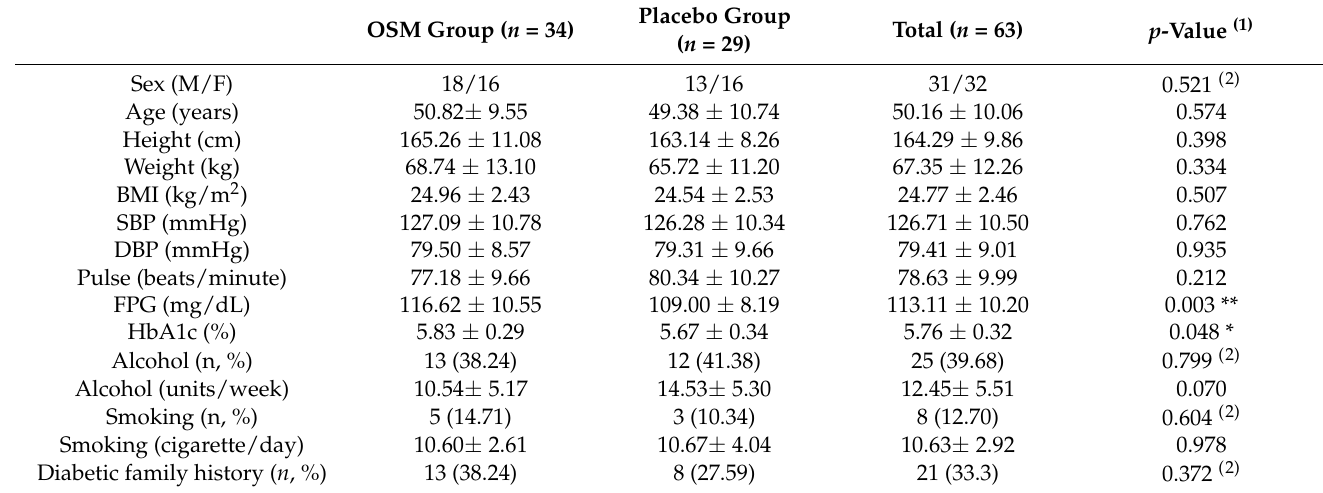
Table 2. Demographic characteristics of the